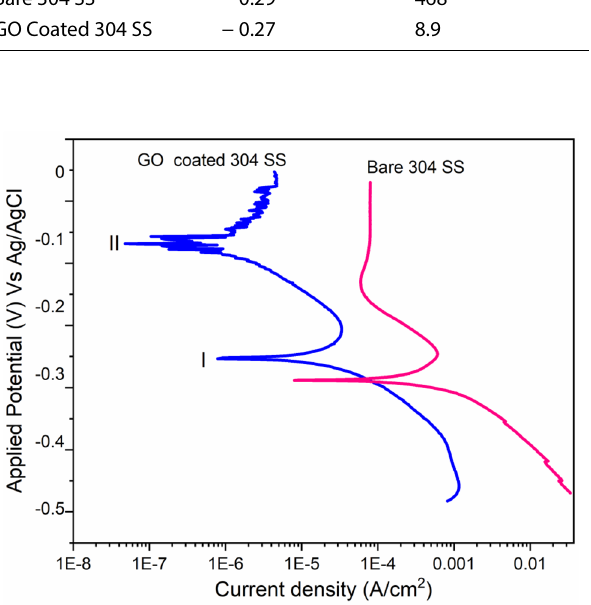
Fig. 3 Potentiodynamic polarization curves of GO coated 304SS and bare 304SS in simulated PEM cell electrolyte (0.5 M H 2 ppm